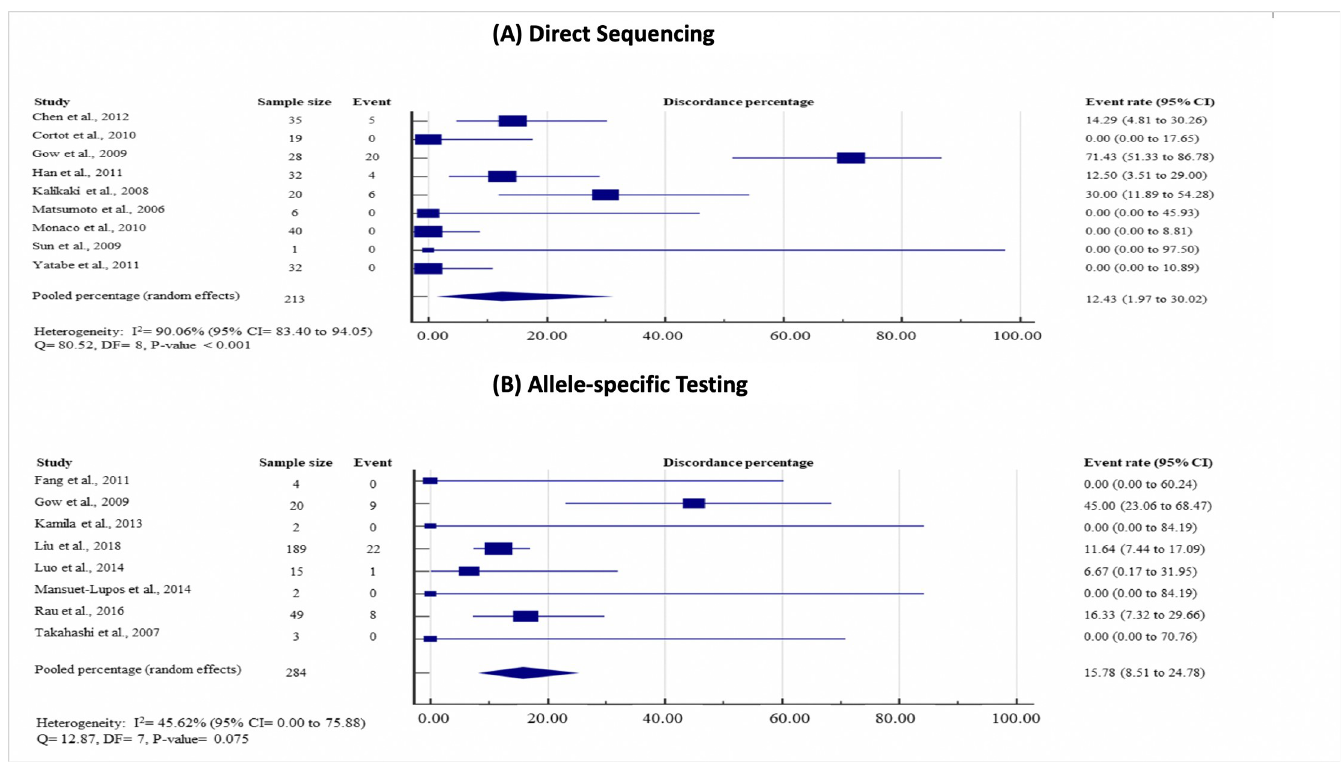
Fig 5. Study-specific and pooled estimates for EGFR mutation discordance percentages by testing methods. (A) Direct sequencing; and (B) allele-specific testing. Heterogeneity was assessed using I 2 and Q test. Event was defined as discordance of EGFR mutation status between primary lung tumor and paired metastases. Abbreviation: DF = degree of freedom, CI = Confidence interval, EGFR = epidermal growth factor status.